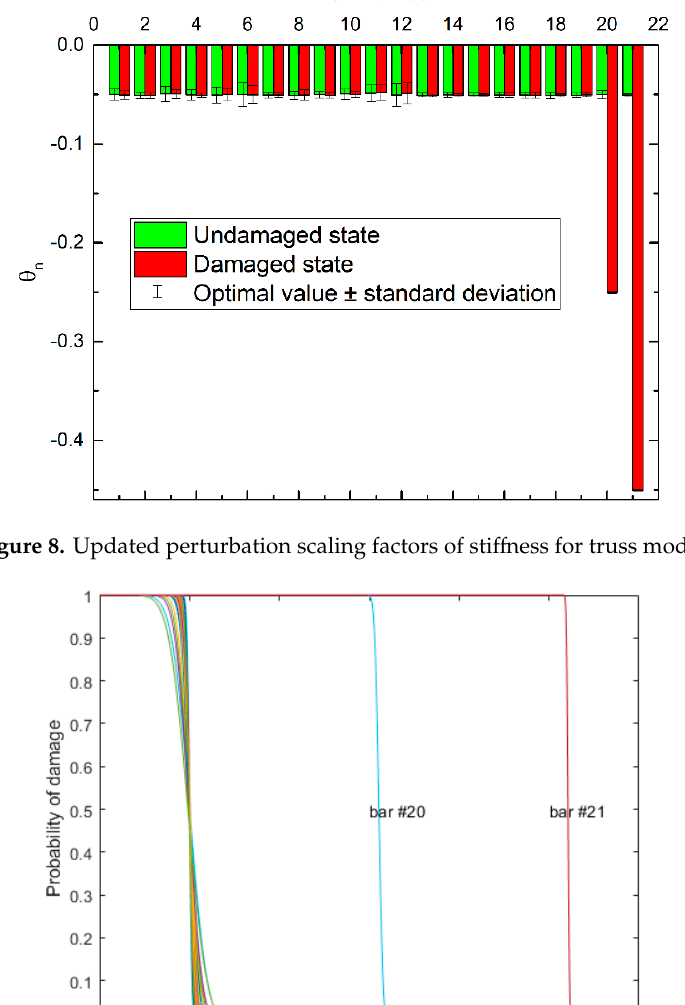
Figure 10. Simply supported beam model. By using the proposed model updating algorithm in Section 3 and the damage assessment method proposed in Section 4, the probability curve of damage extent for each element is shown in Figure 11. It can be seen that there were damages with extents of 10%, 20%, and 30% in elements 5, 8, and 11, respectively, which agreed well with the predefined damaged model.